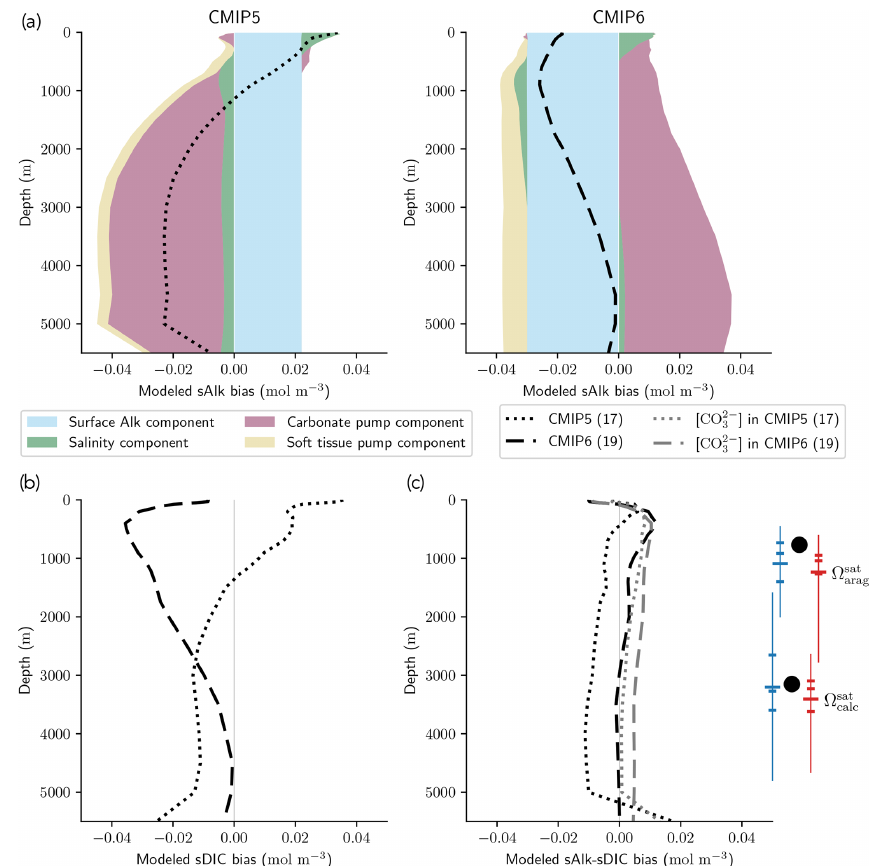
Figure 9. sAlk and sDIC vertical profile biases. (a) Decompositions of the CMIP5 and CMIP6 global sAlk vertical profile biases relative to GLODAPv2 observations. The black dotted (dashed) lines give CMIP5 (CMIP6) ensemble-mean biases. (b) sDIC and (c) sAlk–sDIC vertical profile biases for CMIP5 and CMIP6 ensemble means. The CO 2 − concentration for both ensemble means is also shown in panel 3 (c) as well as the CMIP5 (blue) and CMIP6 (red) ensemble range (line), mean (major tick) and quartiles (minor ticks) of saturation horizon depths in comparison with GLODAPv2 observations (back